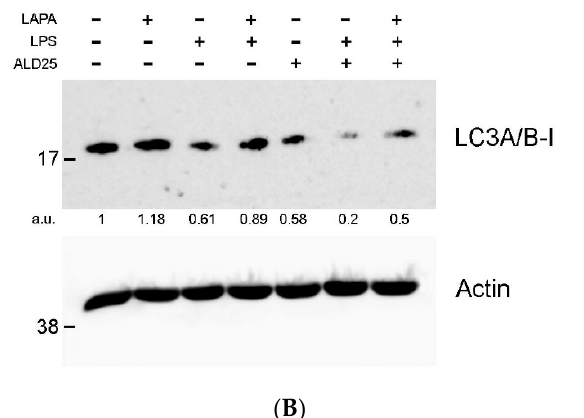
Figure 7. Evaluation of autophagy in RAW 264.7 treated with ALD 25 μ M (ALD25) plus 10 μ g/mL LPS, with or without 10 μ M Lapaquistat (LAPA). ( A ) Representative TEM images of areas of cyto- plasm, 8000× magnification. Scale bars: 2000 nm. Black arrowheads: mitophagosomes. Black arrows: autophagic compartments. ( B ) LC3 protein level was detected by Western blotting analysis. Three independent experiments were conducted; representative blot is shown. β -actin is shown as loading control. The ratio between LC3A-B I/ β -actin densitometric quantification is indicated. a.u.: arbitrary unit.